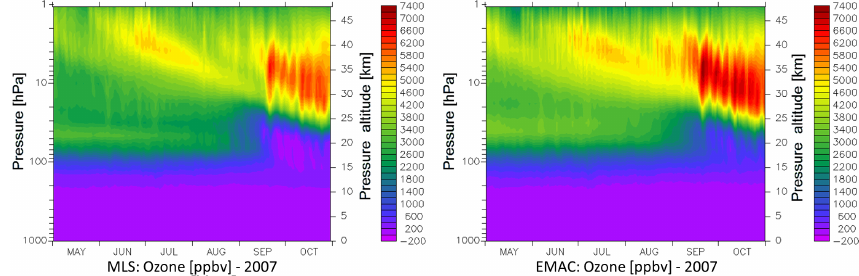
Figure 6. Comparison of O 3 from EMAC with MLS observations – time series of O 3 in ppbv from MLS (left) and from the standard EMAC simulation (right) during Antarctic winter and spring of 2007 in 79.5 ◦